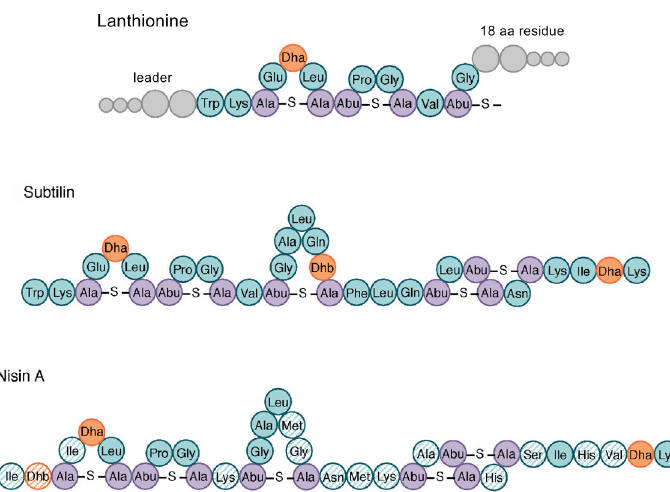
Figure 3. Structures of lanthionine, subtilin and nisin A.